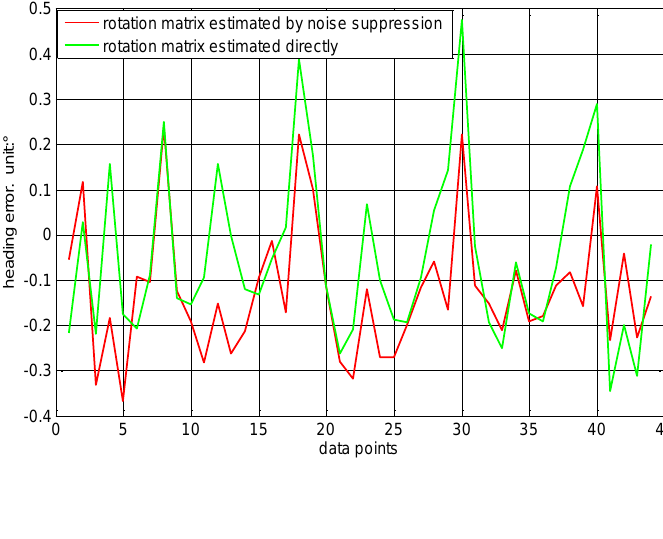
Figure 9. Comparison experiment about the noise suppression